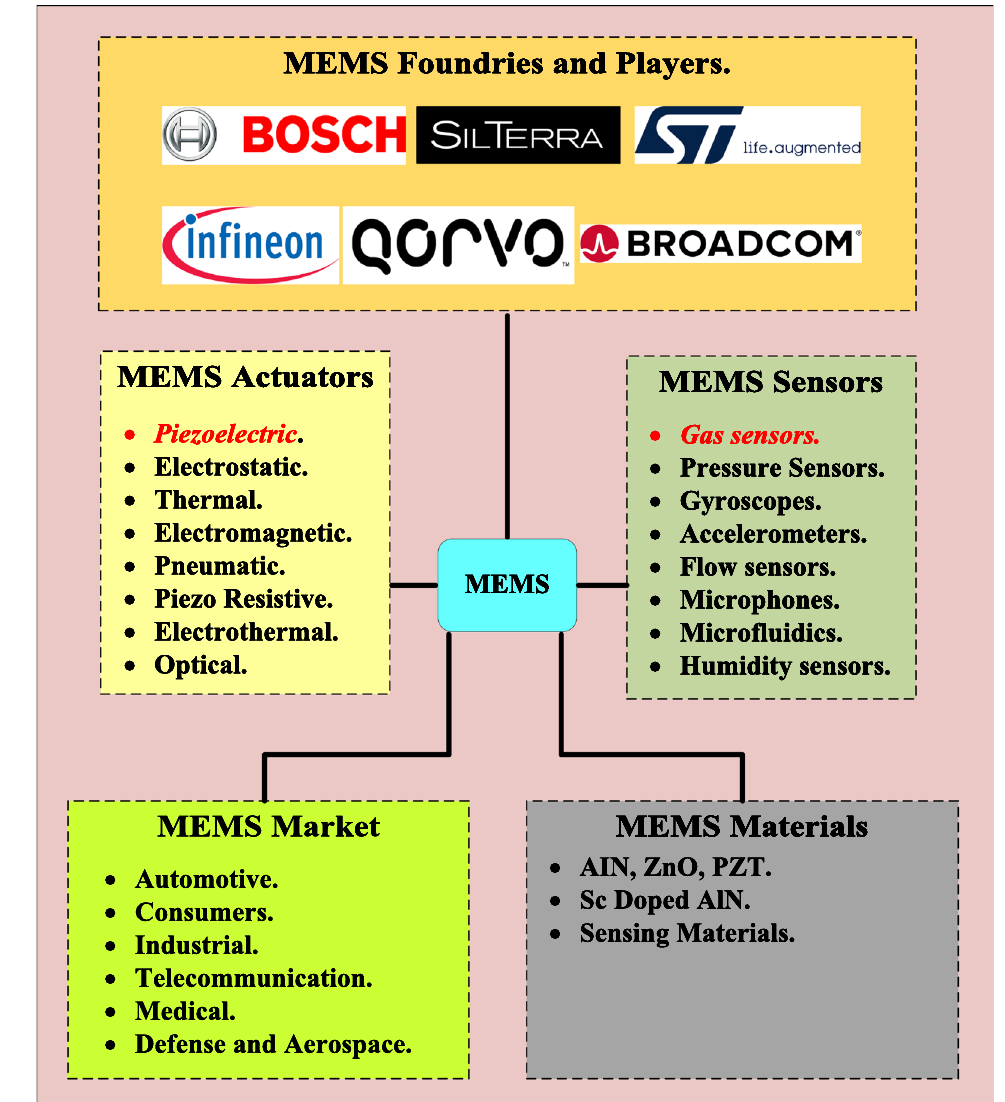
Fig. 1 Overview of the MEMS actuators, sensors, famous foundries, piezoelectric materials and the MEMS